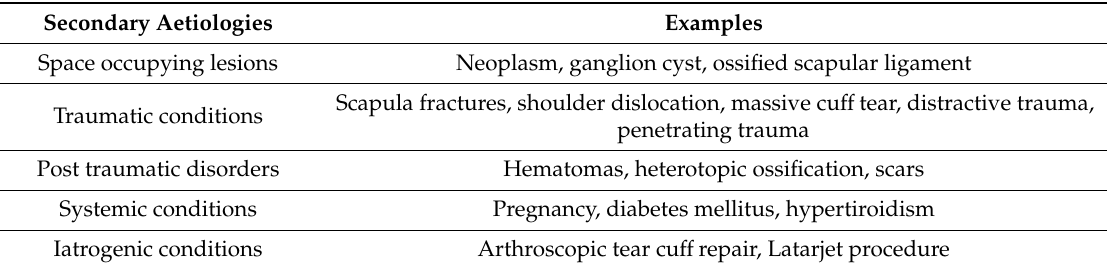
Table 1. Summary of the main secondary